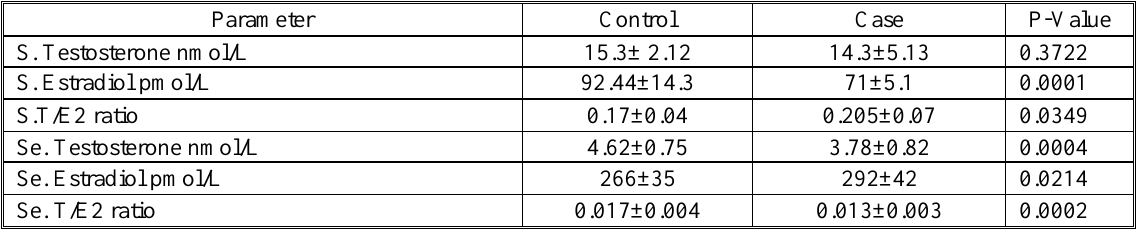
Table 2. Serum and seminal plasma testosterone, estradiol and testosterone/ estradiol ratio in young infertile male in compare to healthy controls